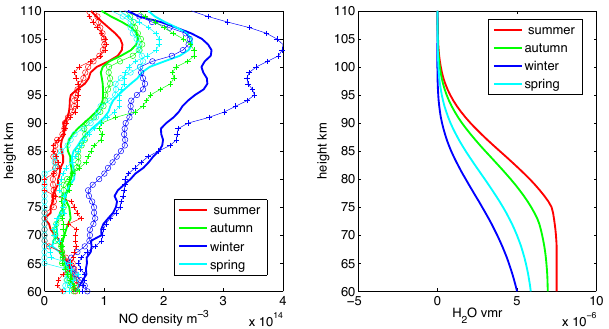
Figure 2. Model profiles of NO number density and H 2 O volume mixing ratio input into the ionization rate/ion-chemistry model. NO profiles are divided according to their relation to the arrival of high- speed solar wind streams: solid lines correspond to days including HSS arrival (onset-HSS), circles for days immediately prior to ar- rival (pre-HSS), crosses at least 1 day after arrival (post-HSS). See text for further